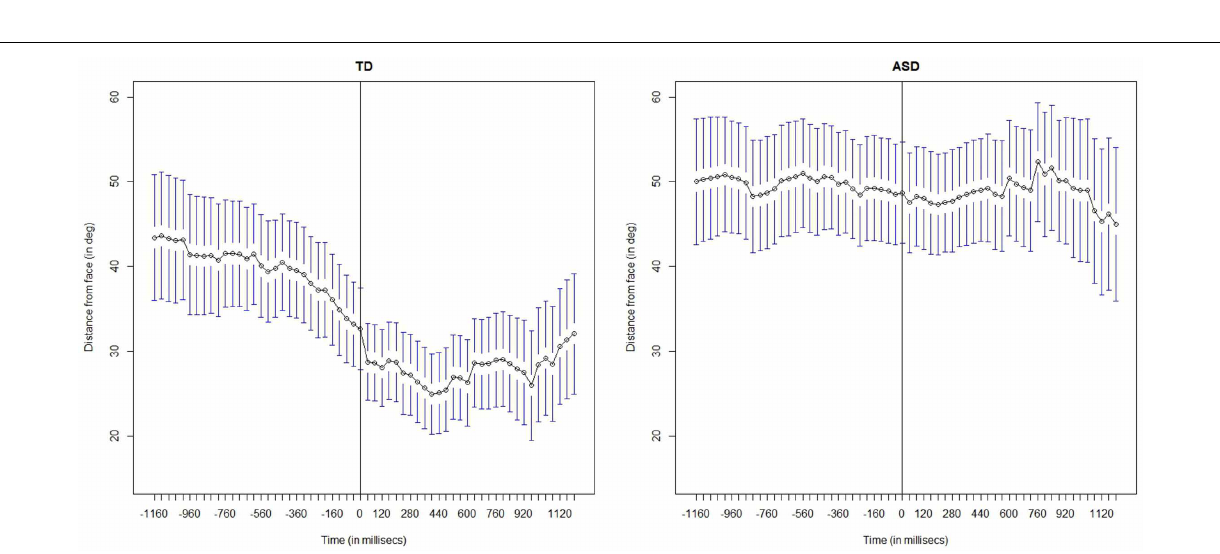
FIGURE 6 | Speaking condition: frame-by-frame plot of the face-to-gaze distance, for the TD children (on the Left) and for the children with ASC (on the Right). Mean and quartiles of the temporal profiles the viewing